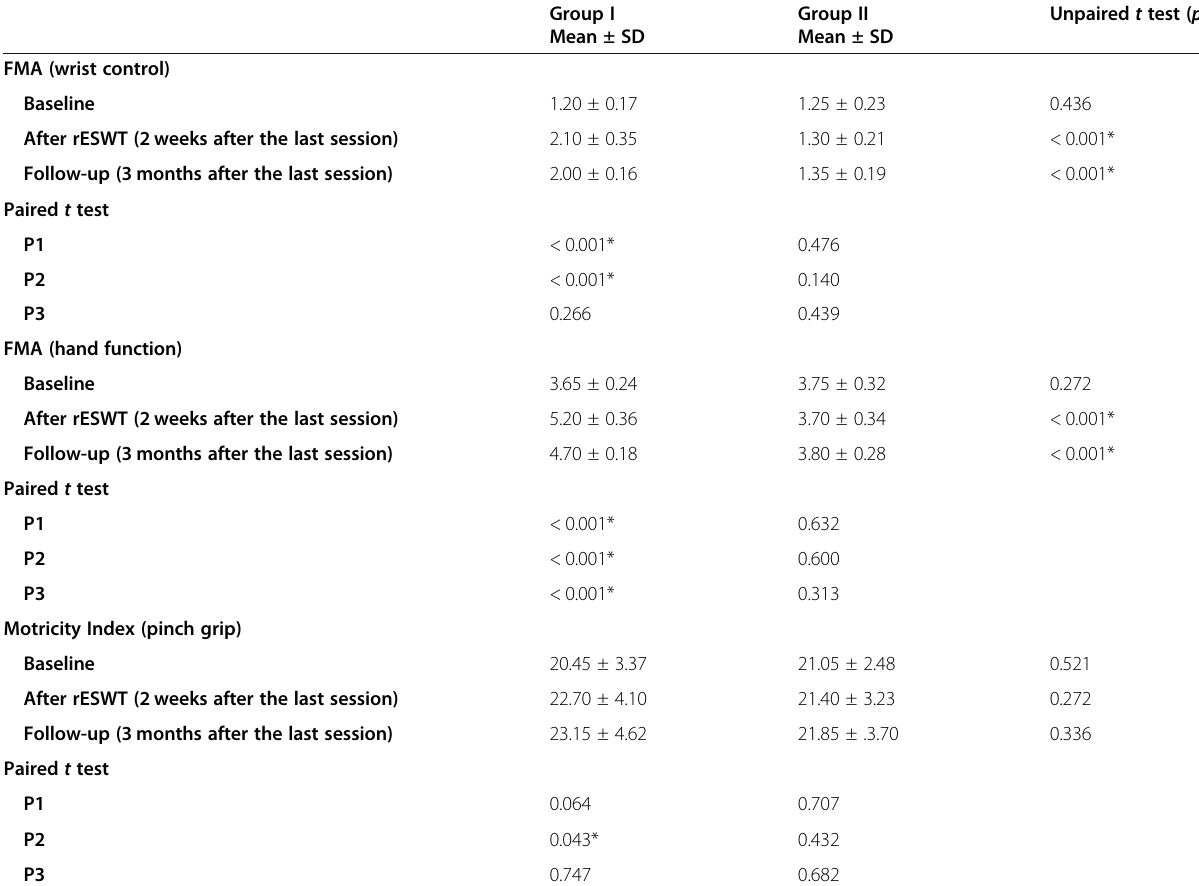
Table 3 Fugl-Myer Assessment (FMA) of hand function and wrist control and Motricity Index (pinch grip) in the studied groups at baseline, after rESWT, and at follow-up showing significant improvement of FMA in GI after receiving rESWT therapy relative to baseline and in comparison to GII and significant improvement of Motricity Index at follow-up period in